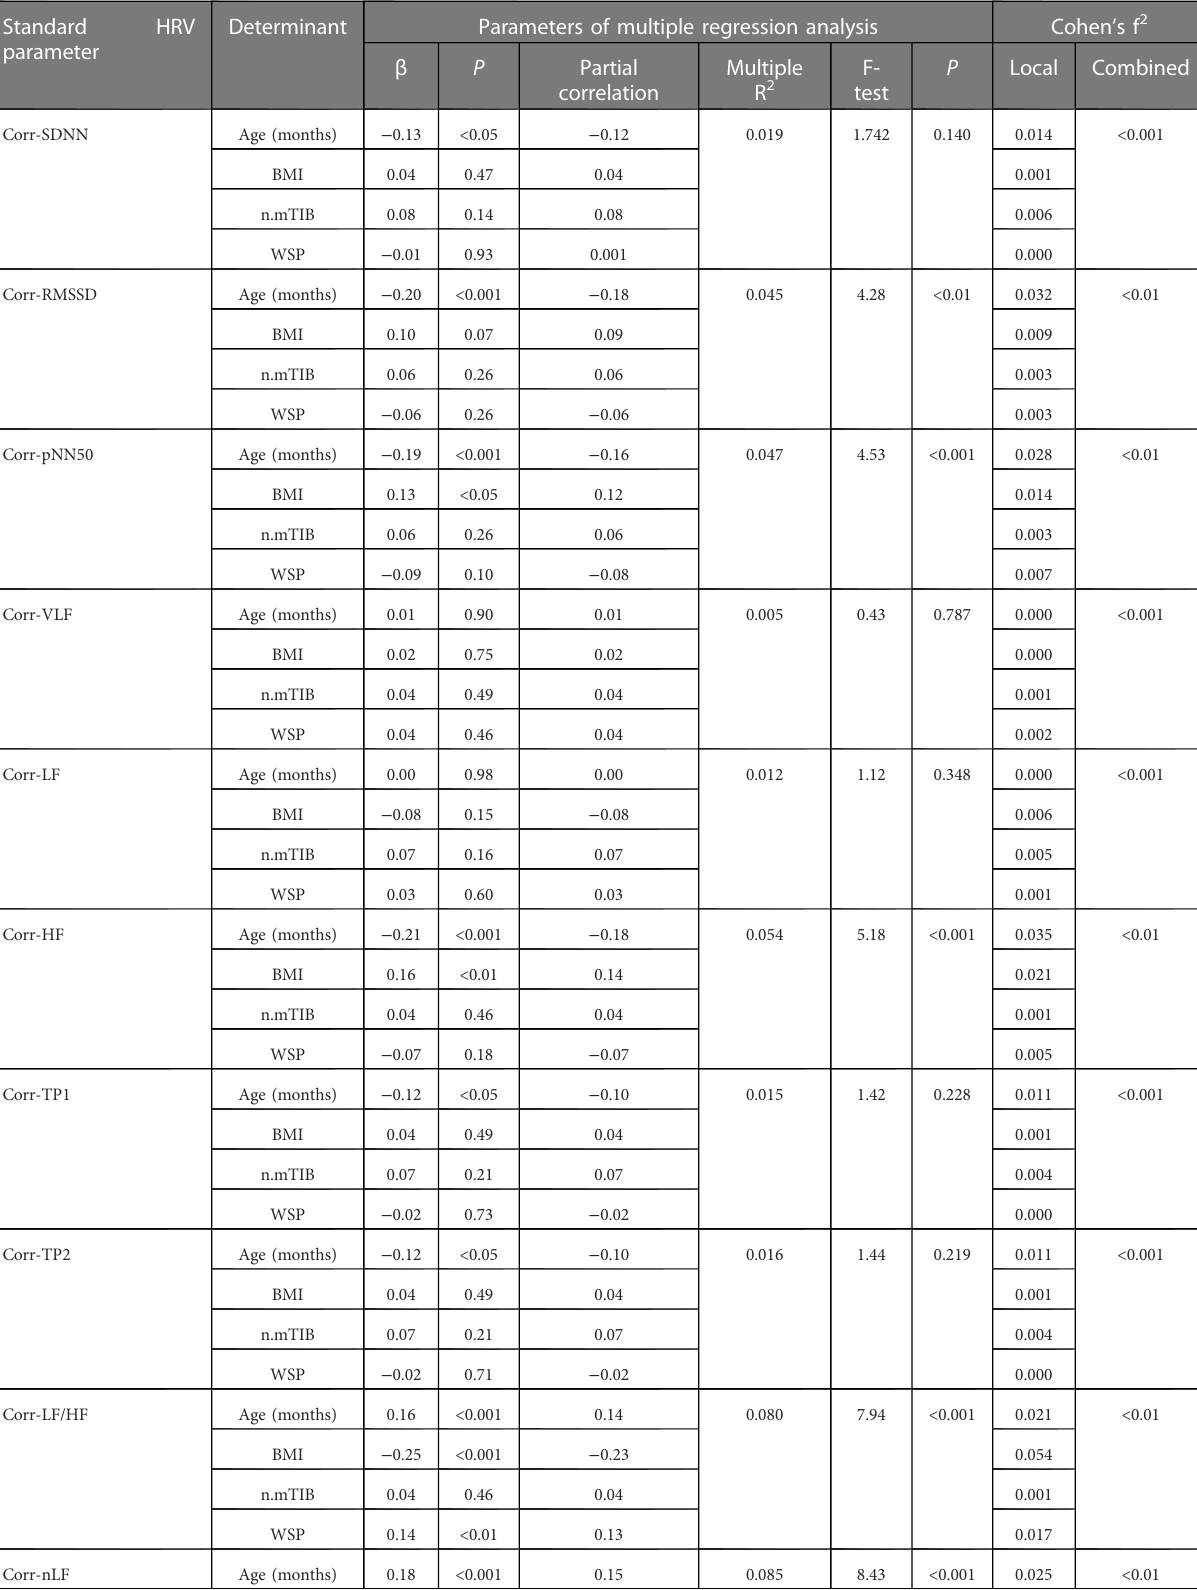
TABLE 5 Determinants and Cohen ’ s f2 indexes for corrected time- and frequency-domain HRV parameters calculated with fast-Fourier